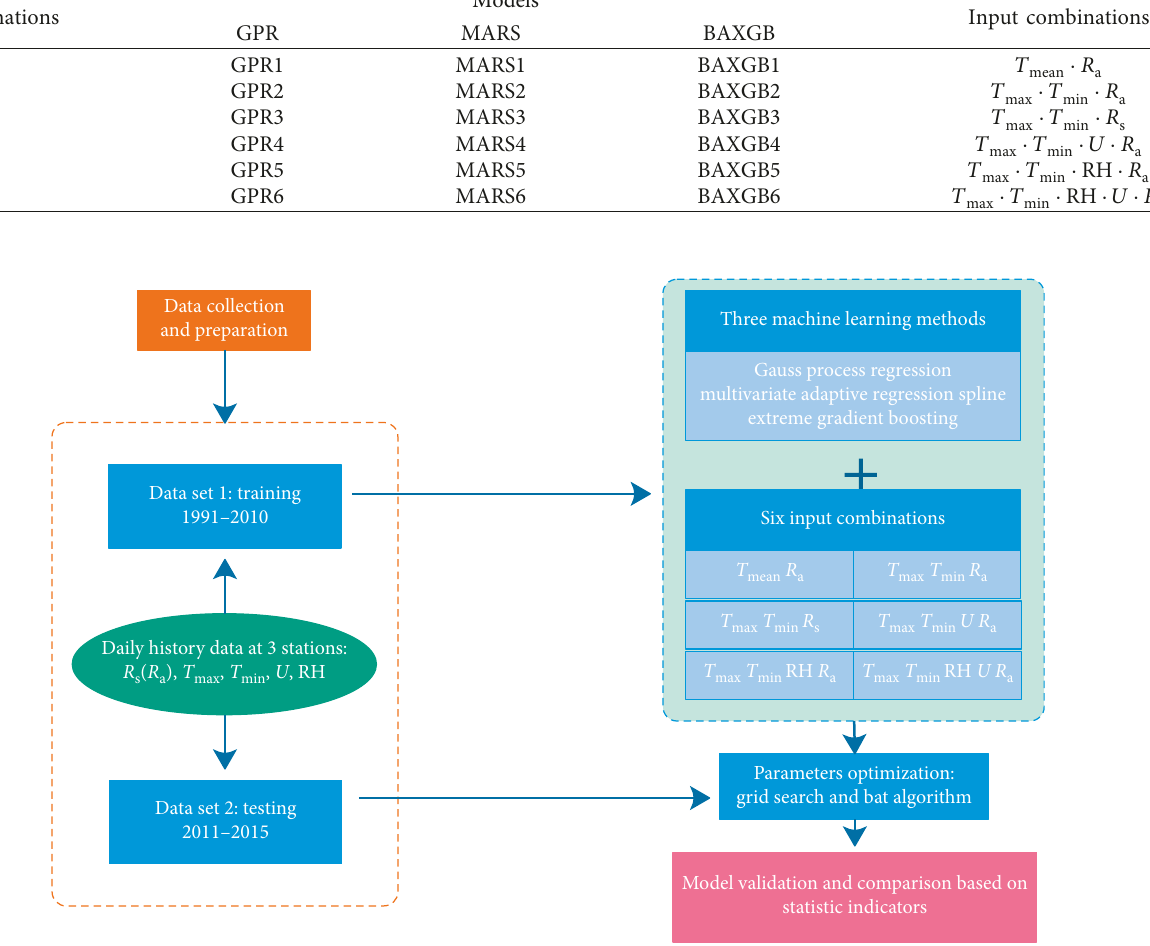
Figure 2: The technology roadmap of the three algorithms in this study.